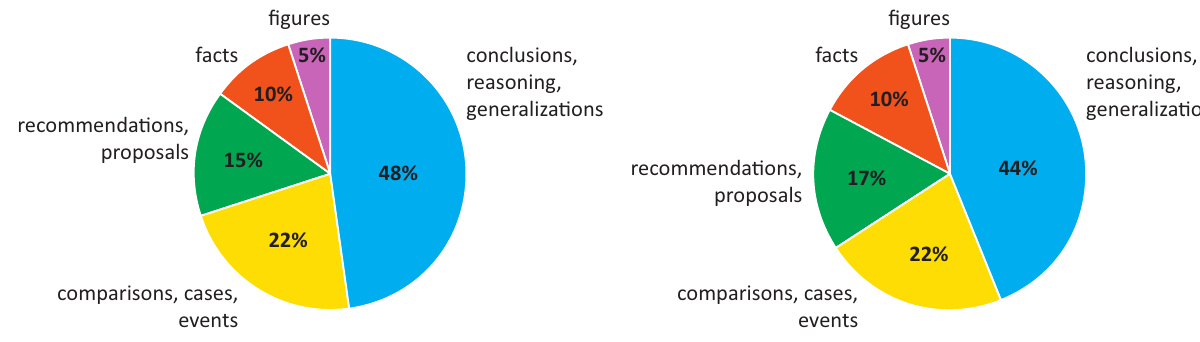
Figure 2. Use of argumentation on pro-government and independent